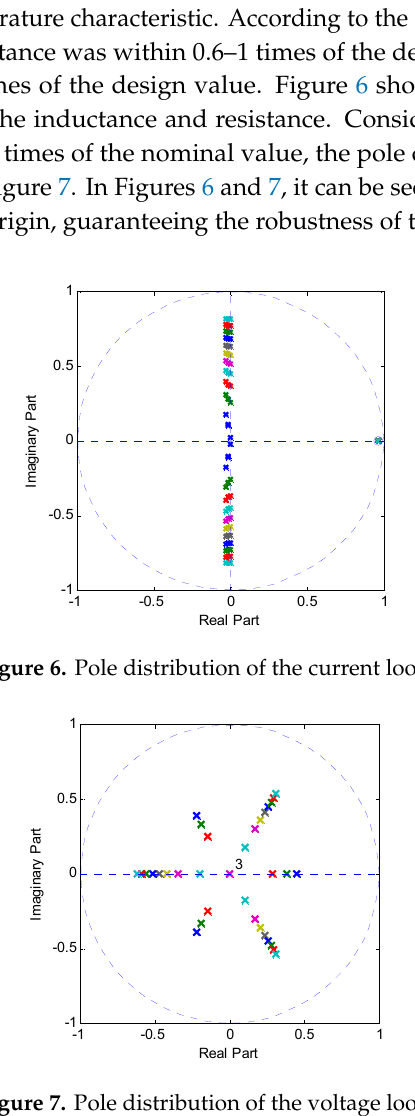
Figure 7. Pole distribution of the voltage loop.